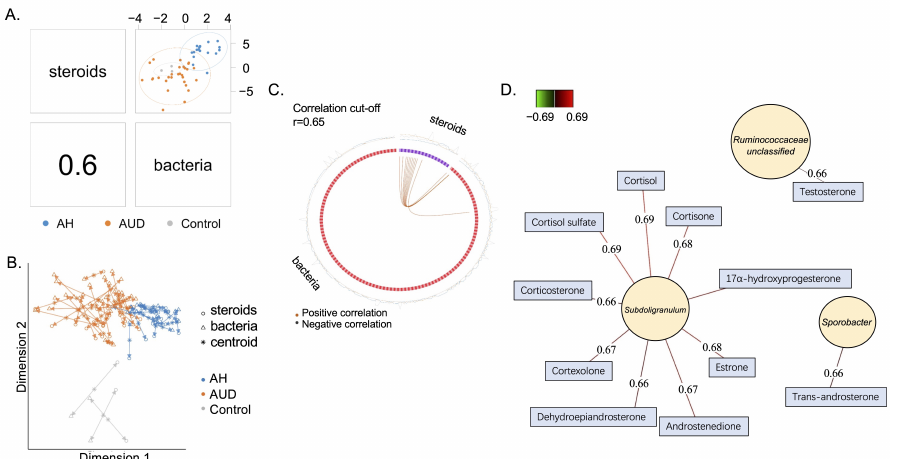
Figure 3. Correlated serum steroids and gut bacteria. ( A ) The overall correlation between serum steroids and gut bacteria is 0.6. ( B ) Integrative analysis between serum steroids and gut bacteria. Each sample corresponds to one arrow, with short arrows indicating strong agreement between two data sets and long arrows indicating a disagreement. ( C ) Correlations between serum steroids and gut bacteria with a cut-off set to 0.65. Orange line: positive correlation. ( D ) Correlations between serum steroids and gut bacteria. Ctrl, control subjects, AUD, patients with alcohol use disorder; AH, alcohol-associated hepatitis.